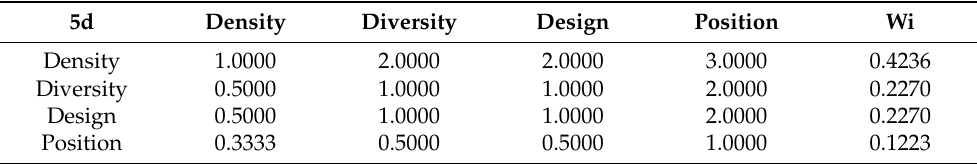
Table A8. 5D consistency ratio: 0.0039; Weight of “5D”: 1.0000; λ max: 4.0104.